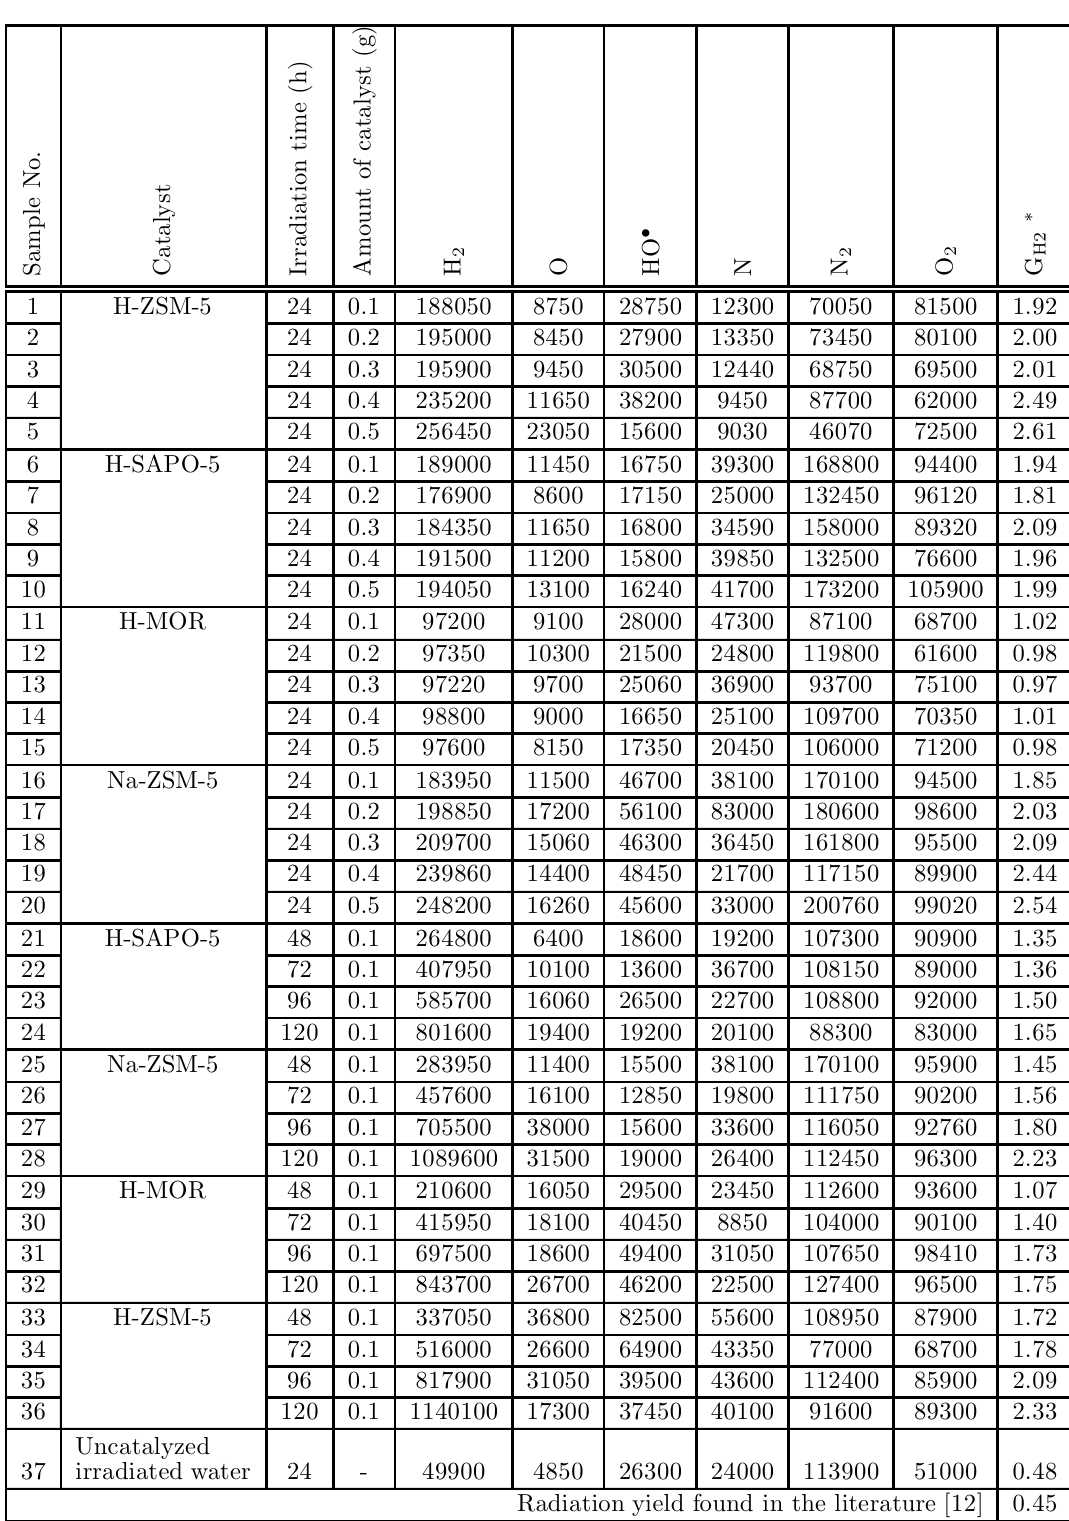
Table 2 Peak intensities (in arbitrary units) of the main species and radiation yields (G H the given experimental